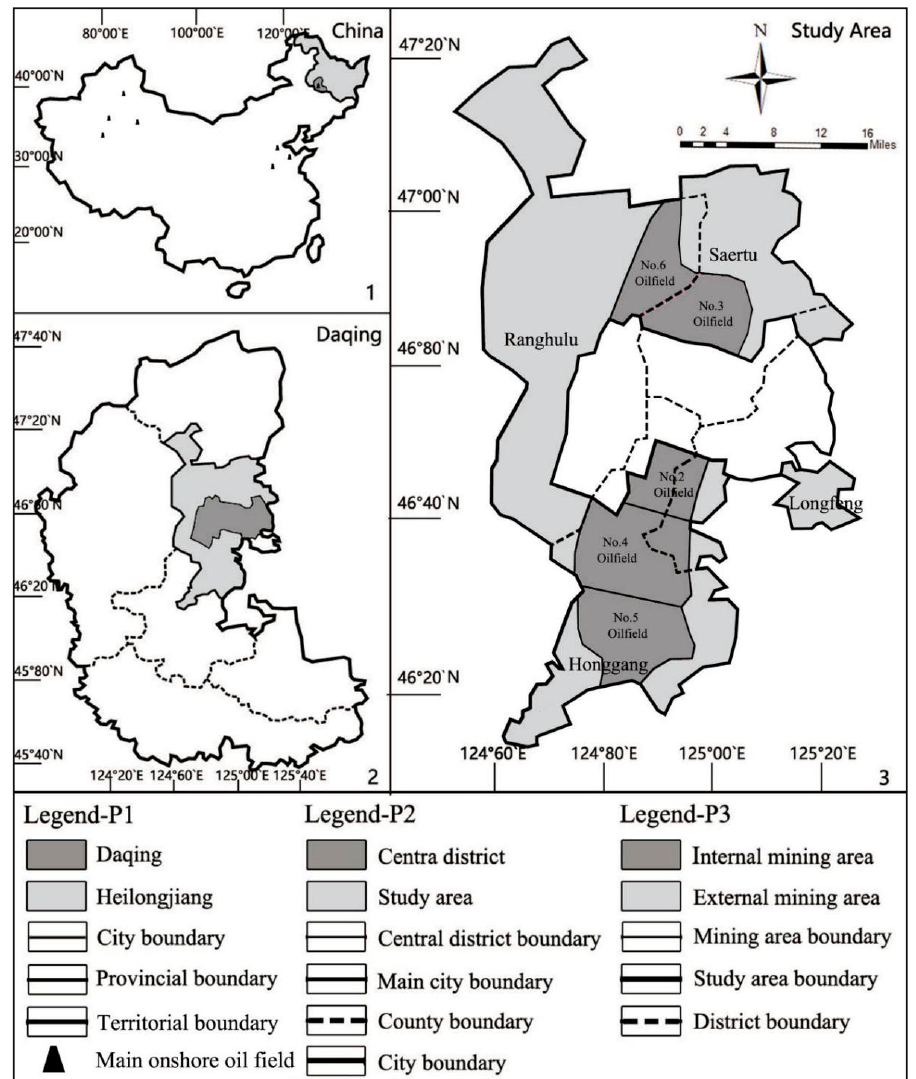
Figure 1. Location of the study area.